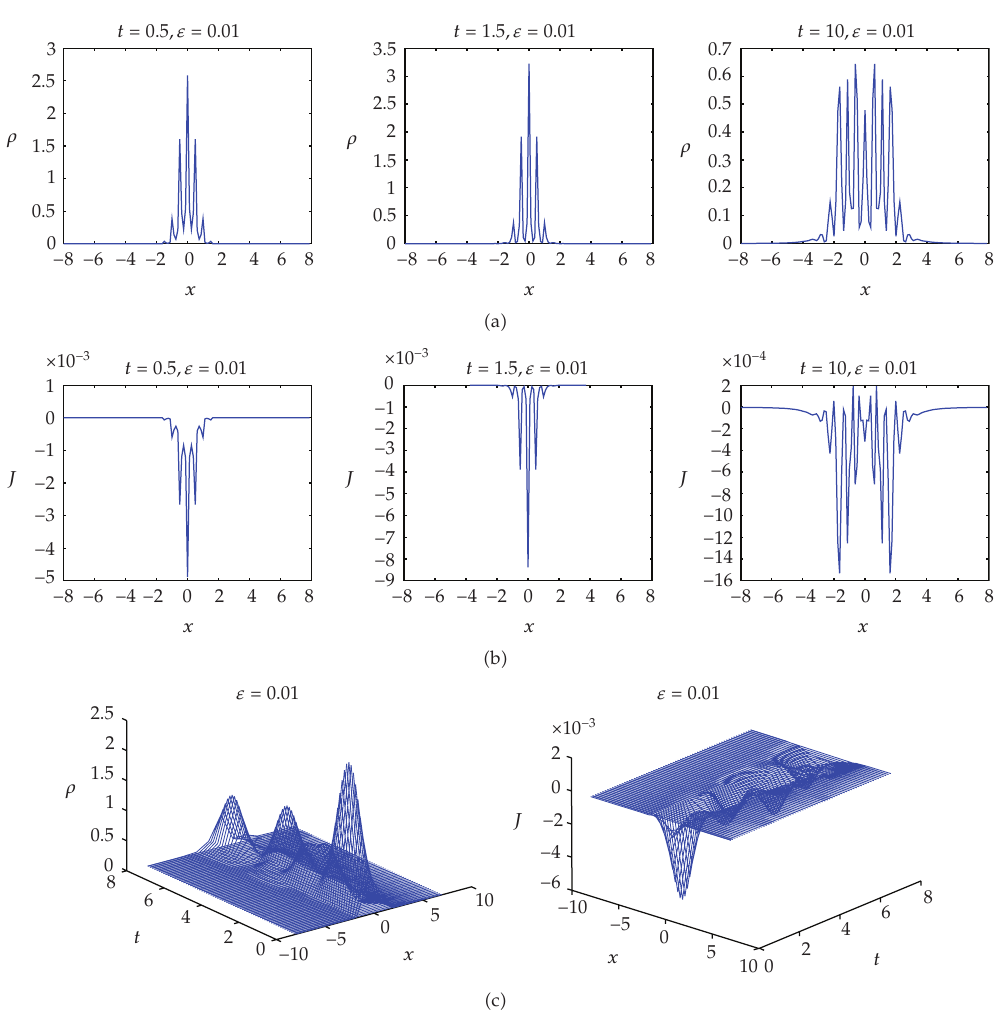
Figure 7: Numerical solutions of Example 5.2 by ED2/EP2 for the weak O (cid:3) ε 3 / 2 (cid:4) defocusing nonlinearity (cid:3) ε (cid:6) 0 . 01 (cid:4)